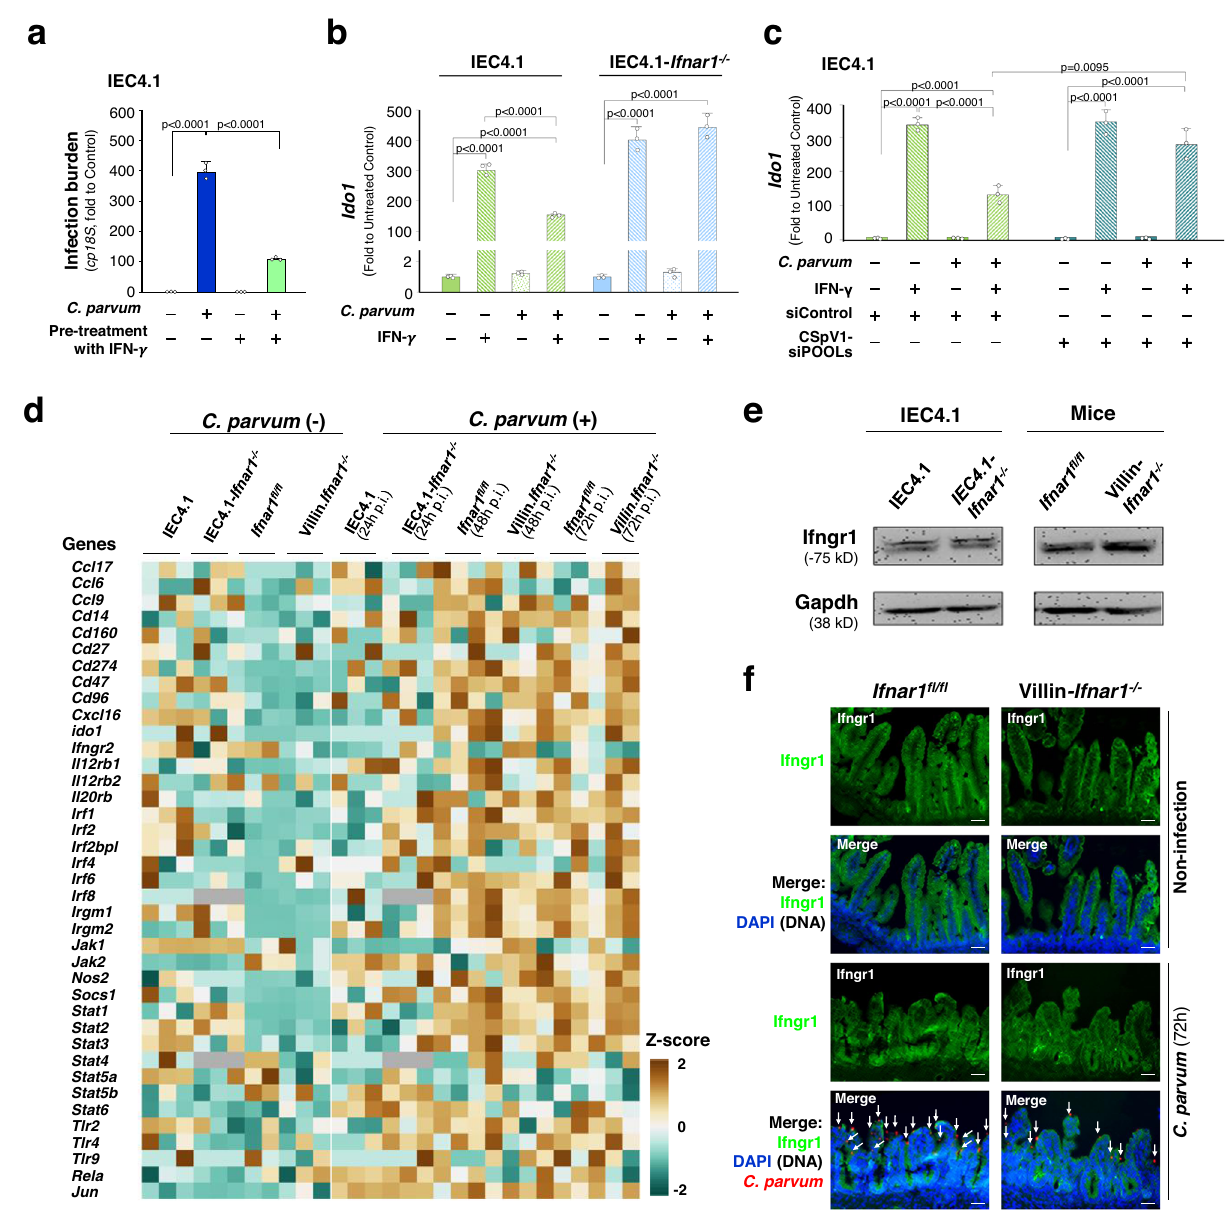
Fig. 6 | Impaired cellular response to IFN- γ stimulation in infected epithelial cellsanditsassociationwith C.parvum -inducedtypeIIFNsignalingactivation. a Pre-treatment of IEC4.1 cells with IFN- γ decreased C. parvum infection burden. Cellswere fi rsttreated withIFN- γ (10ng/ml)for8h,exposedto C.parvum for24h, and cp18S was quanti fi ed by RT-qPCR. b Impaired cellular response to IFN- γ sti- mulation in infected IEC4.1 cells associated with type I IFN signaling. IEC4.1 and Ifnar1 − / − IEC4.1 cells were fi rst exposed to C. parvum infection for 24h followed by IFN- γ stimulation for additional 2h. Cellular response to IFN- γ stimulation was re fl ected by the expression level of the Ido1 gene. c Knockdown of CSpV1-dsRNA delivery in infected IEC4.1 cells through transfection of the speci fi c siRNA combi- nations (siPOOLs) partially restored the induction of Ido1 gene expression in responsetoIFN- γ stimulation.Anon-speci fi ccontrolsiRNA(siControl)wasusedfor control. Data (in a – c ) are from three biological replicates and presented as mean values±SD. p valuesweredeterminedbytwo-wayANOVAfollowedbyTukey ’ sHSD test (in a – c ). d Heatmaps representing altered expression levels of selected genes